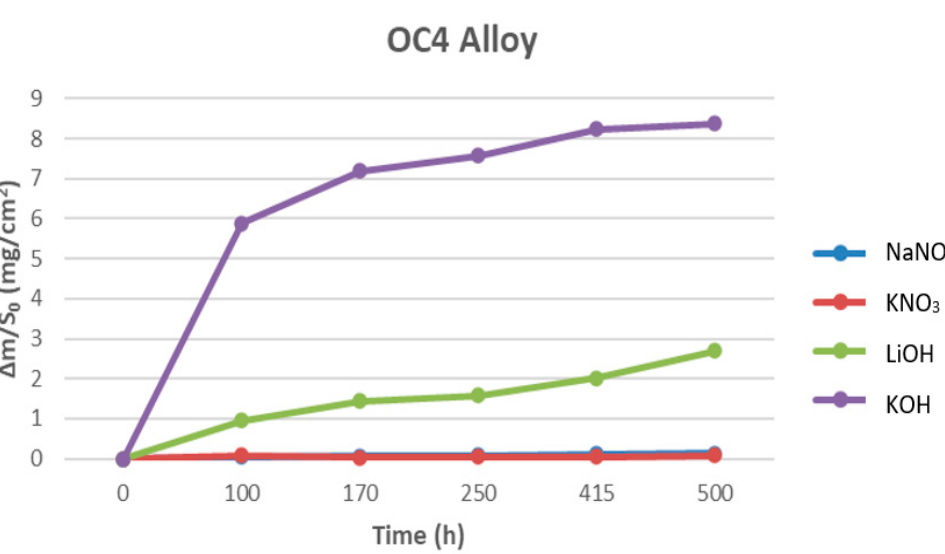
Figure 5. TGA curve for LiOH between 100 and 550 °C.